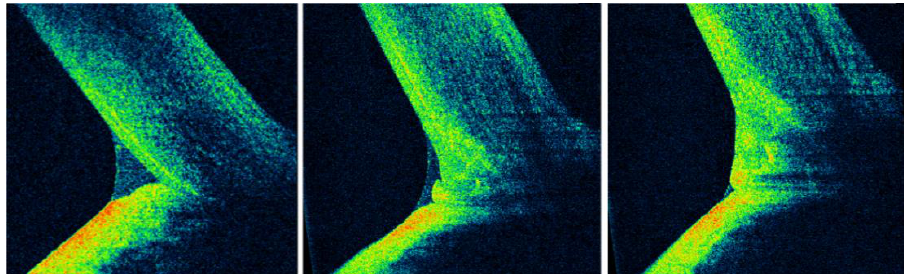
Figure 5. Optical coherence tomography (OCT) imaging of the lower tear meniscus (LTM), lid-parallel conjunctival folds (LIPCOFs), and conjunctivochalasis. The qualitative and quantitative features of the LTM are clearly visible in cross section by means of OCT (left). However, this approach may be invalidated by the presence of LIPCOFs (middle) or conjunctivochalasis (right) [42].